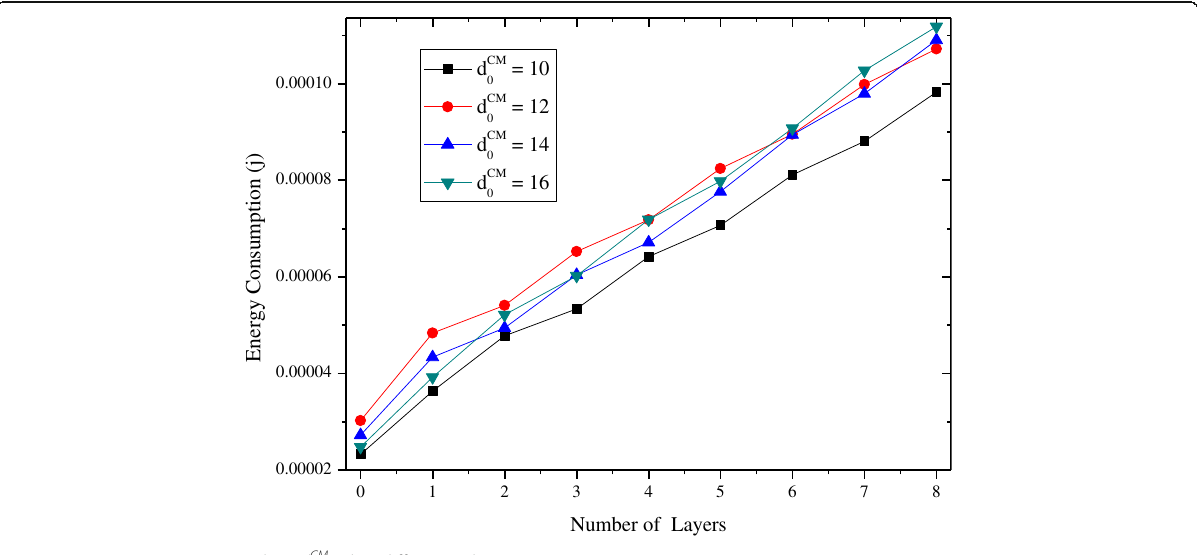
Fig. 14 Energy consumption when d CM